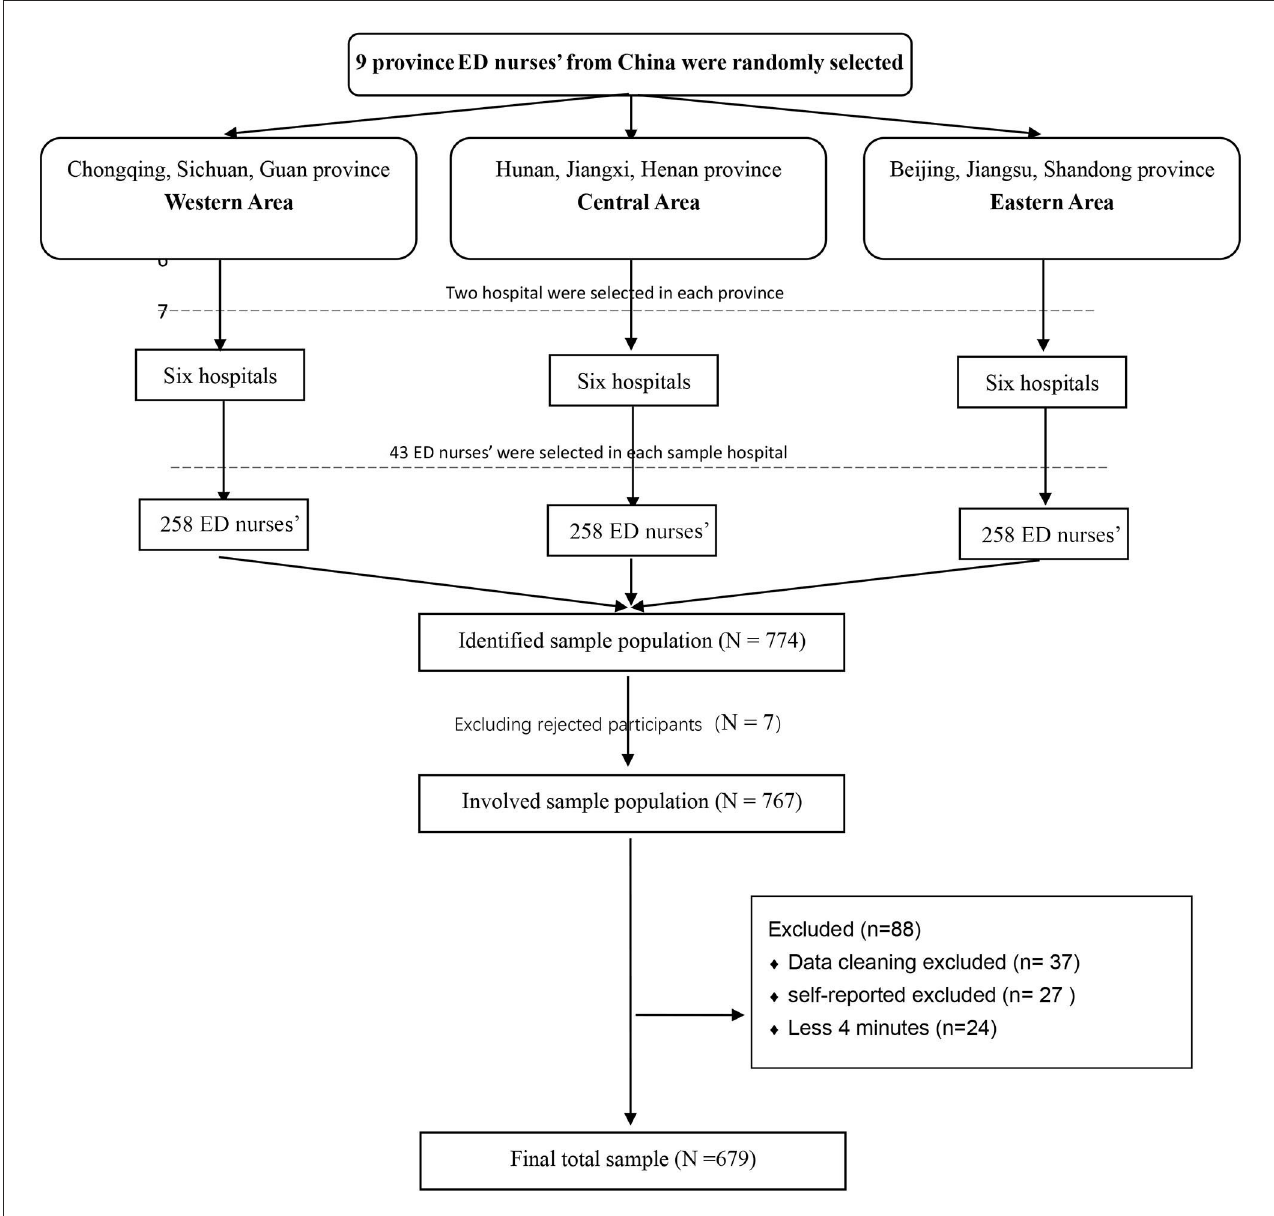
FIGURE1 Flow diagram for the number of participants in each